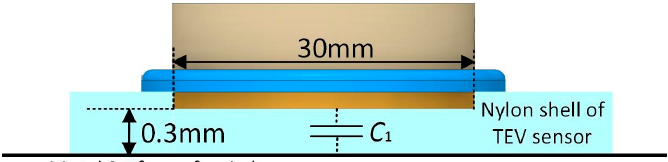
Figure 4. Determination of capacitance C 1 .